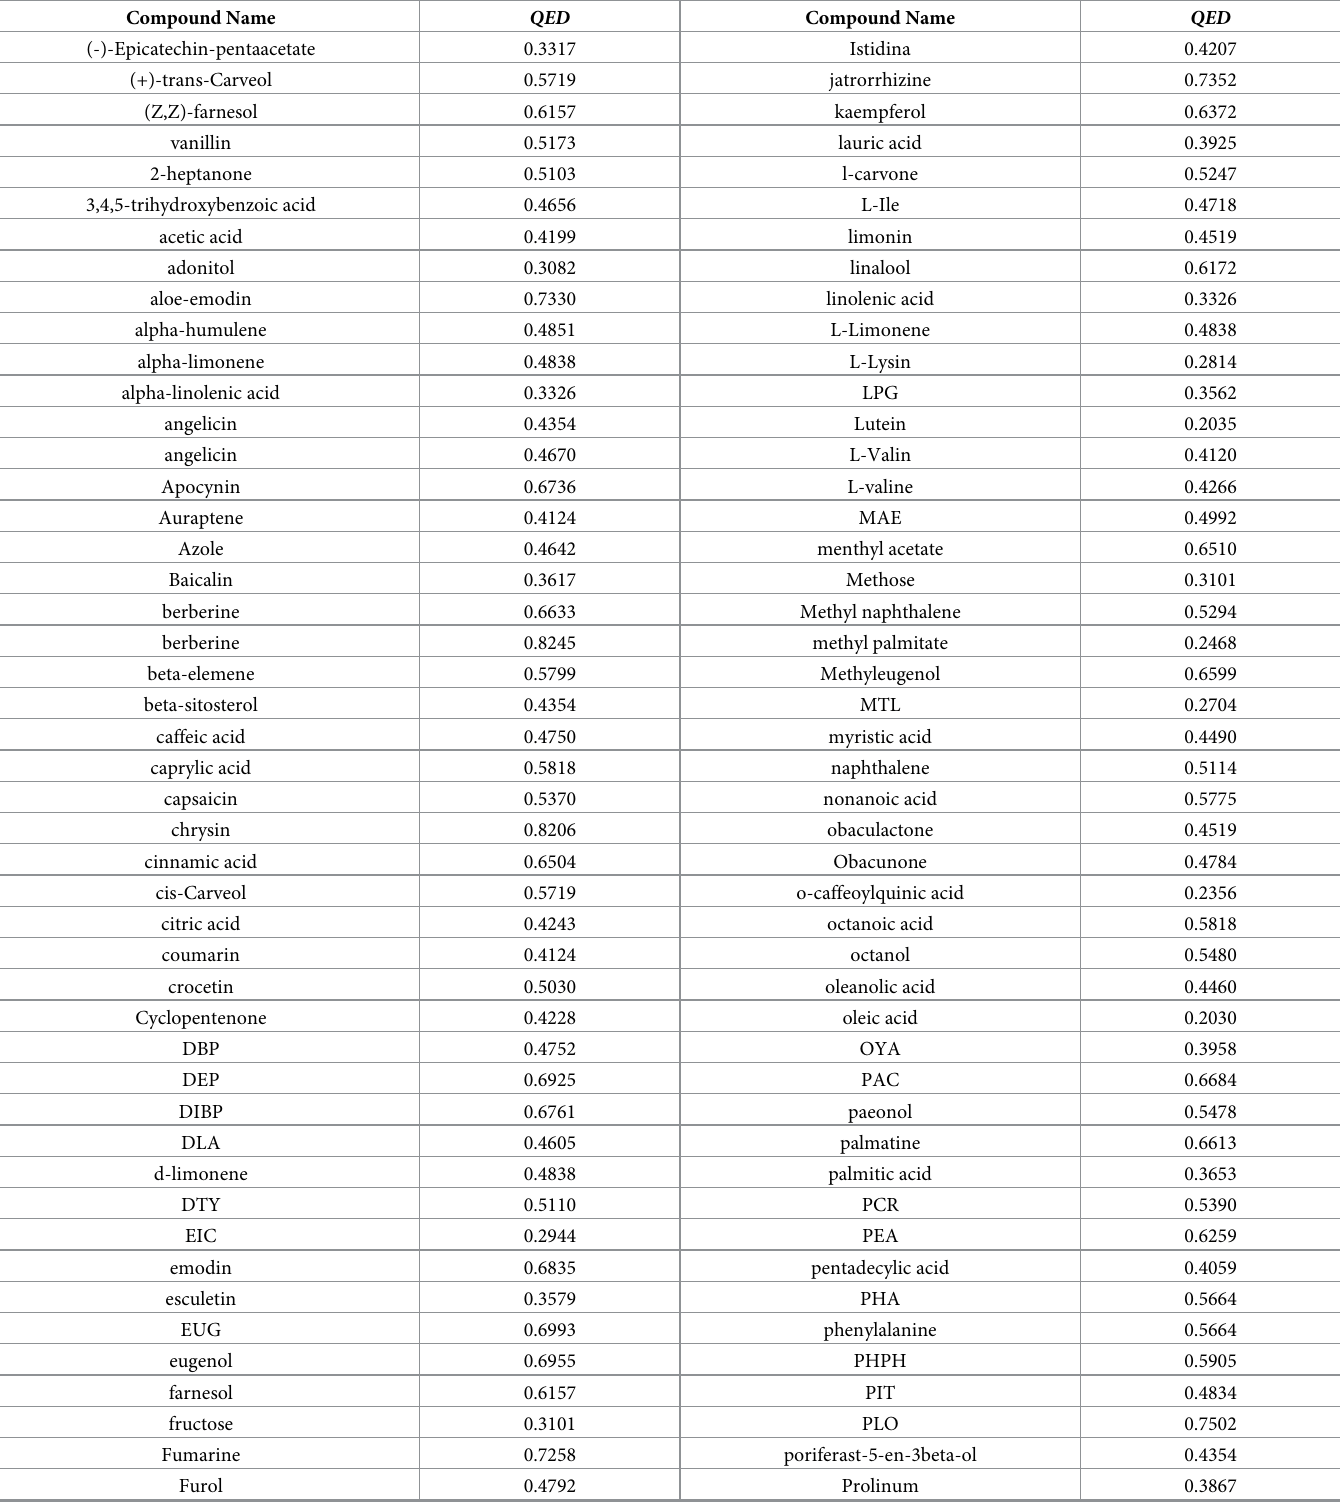
Table 3. 141 bioactive compounds of SHCZF against